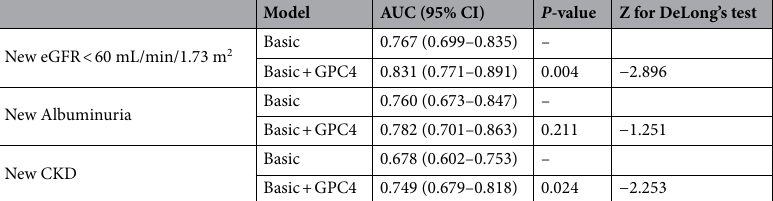
Table 3. Comparison of the area under the curve of prediction models for the incidence of eGFR < 60 mL/ min/1.73 m2, albuminuria, and chronic kidney disease. Models were built as binary logistic regression models. The basic model comprises the albumin/creatinine concentration ratio, age, sex, BMI, blood pressure, type 2 diabetes mellitus, C-reactive protein, smoking, and presence of coronary artery disease. The basic model was compared with a model including variables of the basic model and additionally serum glypican-4. AUCs were compared according to DeLong’s test; respective P- values are given for the comparison with the basic model. AUC, area under the curve; CI, confidence interval; CKD, chronic kidney disease, GPC4,